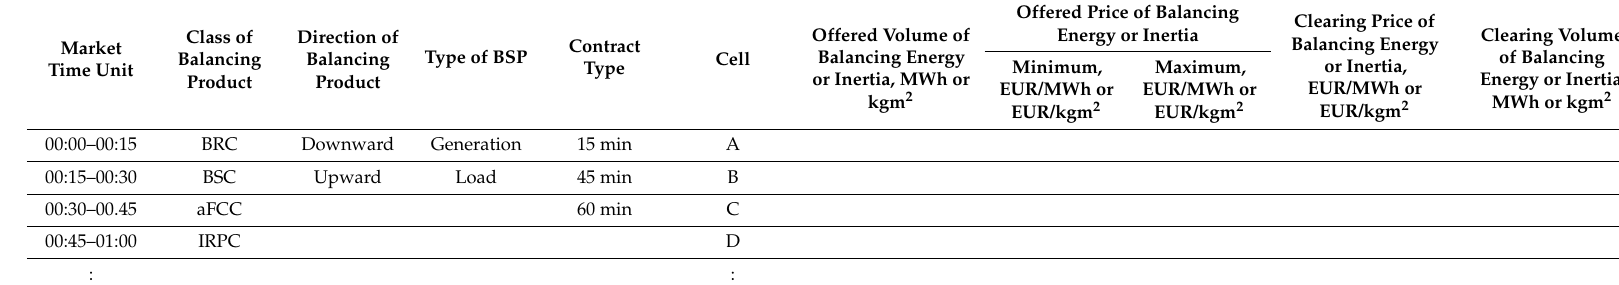
Table 2. Publication of aggregated data related to the trade in inertia and balancing energy.